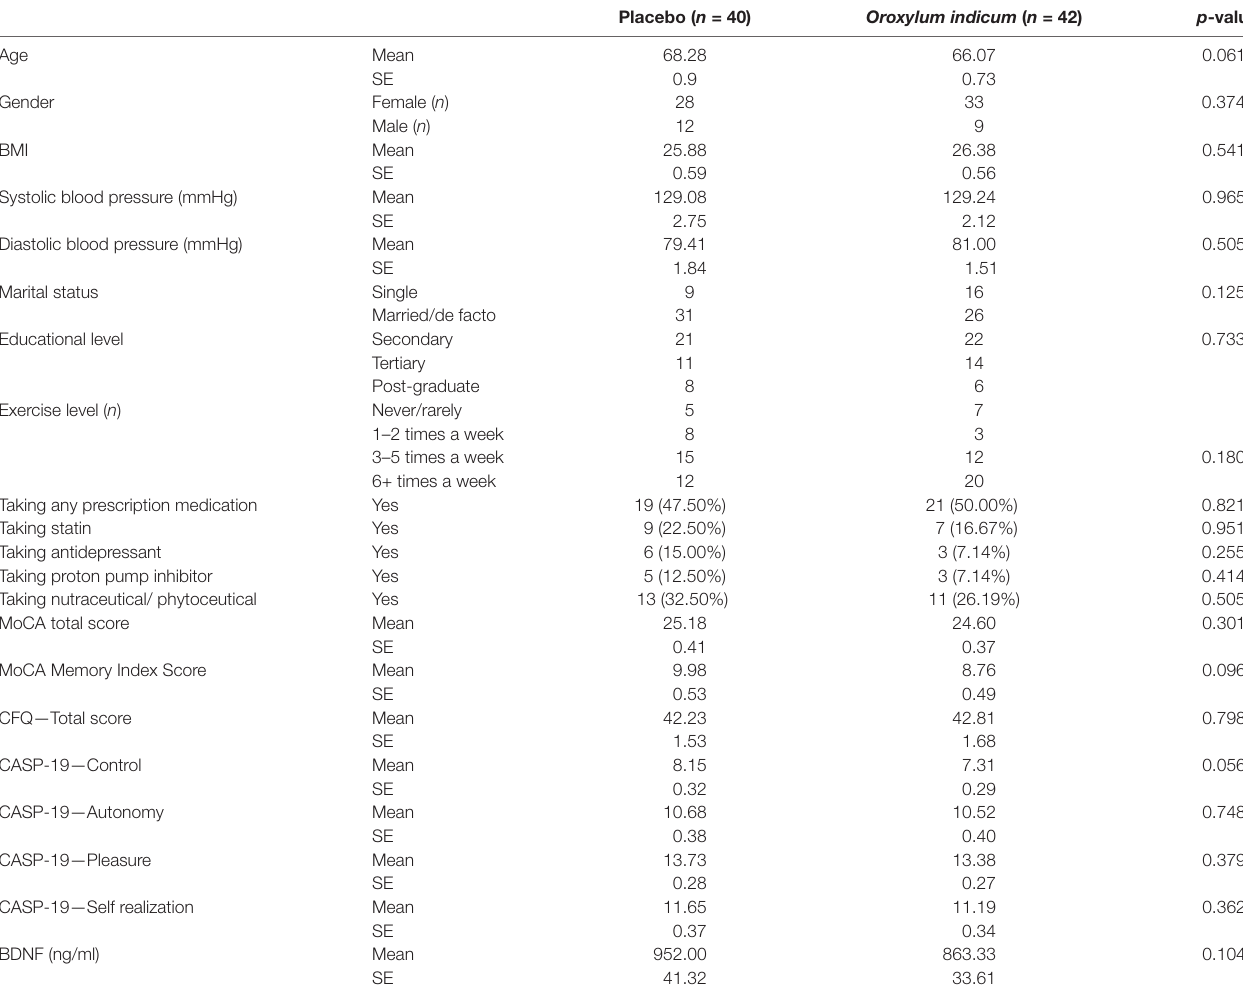
TABLE 2 | Baseline demographics details and questionnaire